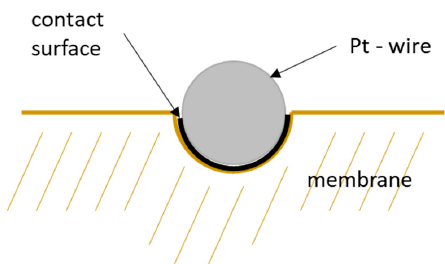
Figure 11. Schematic illustration of the contact surface of a platinum wire of the mesh.